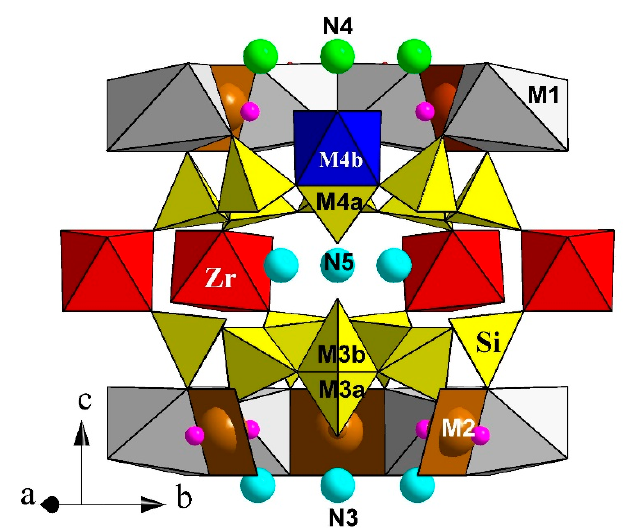
Figure 8. A fragment of the crystal structure of andrianovite.